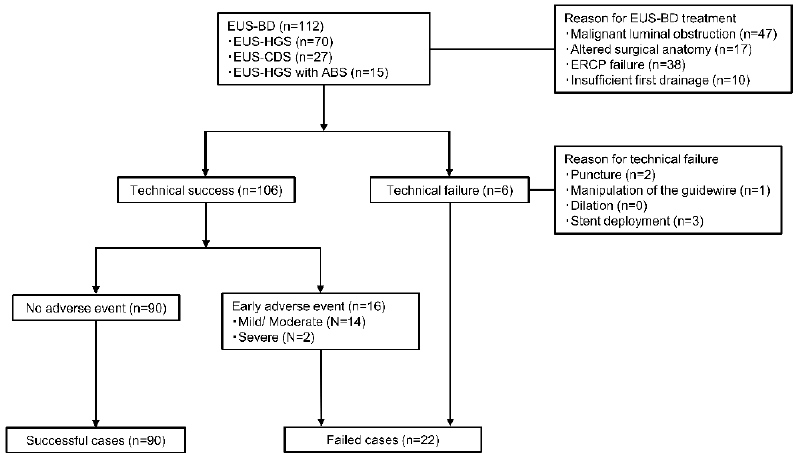
Figure 1. Flow diagram of the study design. ABS, antegrade biliary stenting; BD, biliary drainage; CDS, choledochoduodenostomy; ERCP, endoscopic retrograde cholangiopancreatography; EUS, endoscopic ultrasound; HGS, hepaticogastrostomy.